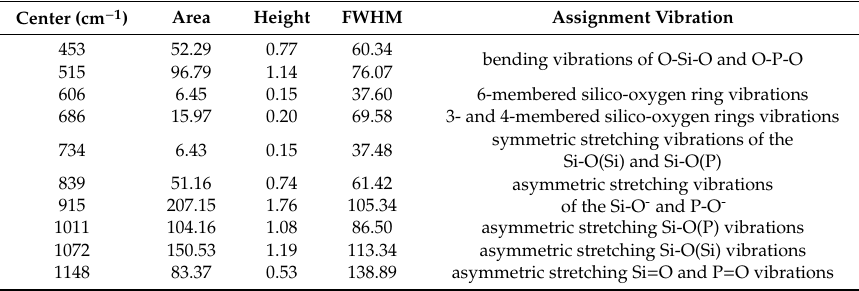
Table 5. Parameters of the component bands of the MIR spectrum of the 45S5_4h sample